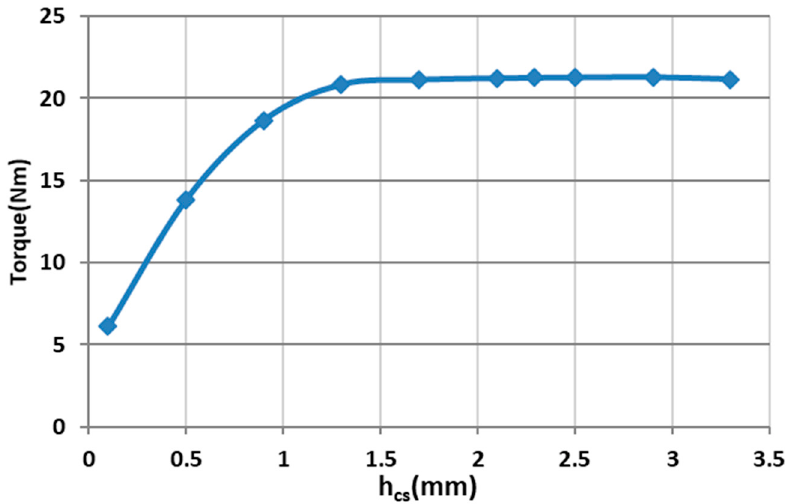
Figure 34. FEA results for h cs effect on the Torque.